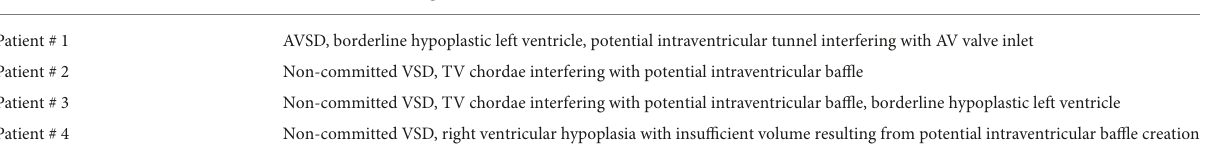
TABLE 4 Decision-making in DORV patients with